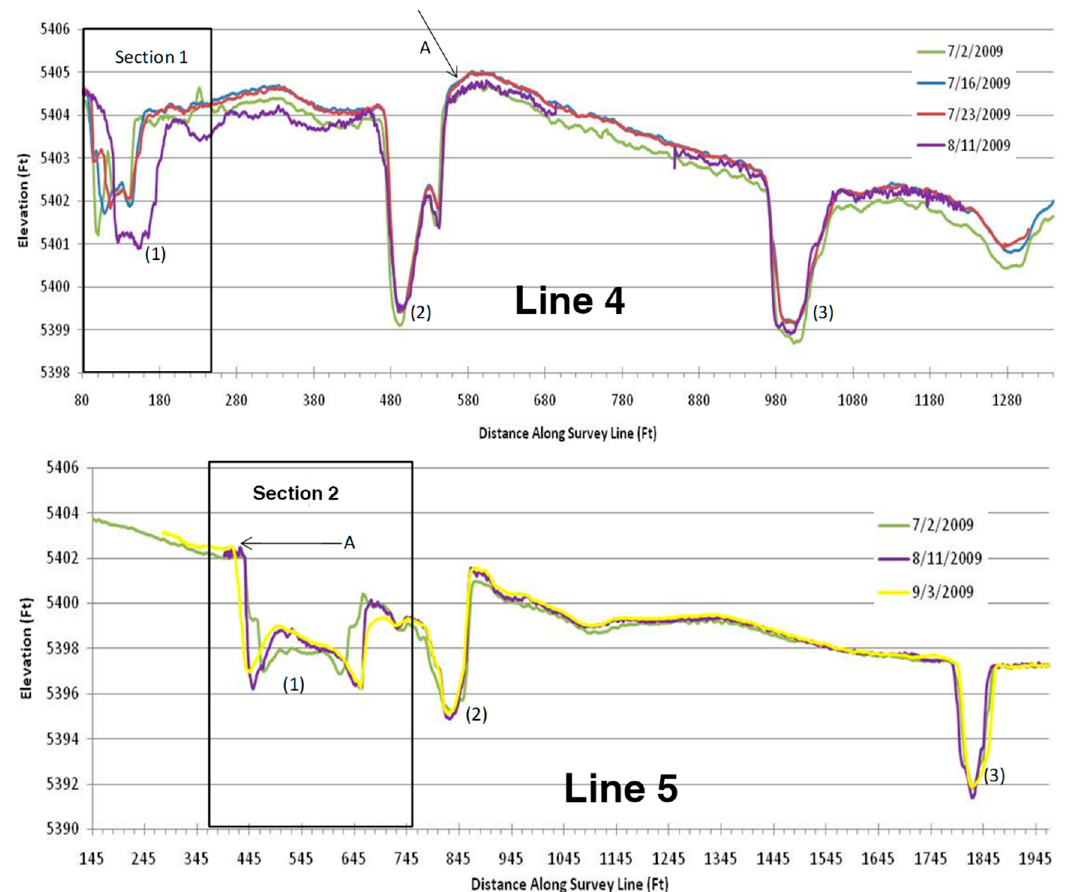
Figure 8. Results for Survey Lines 4 and 5. The left channel (Section 1) on Line 4 shows significant recutting with the channel moving deeper and to the right of figure. recutting with the channel moving deeper and to the right of figure.